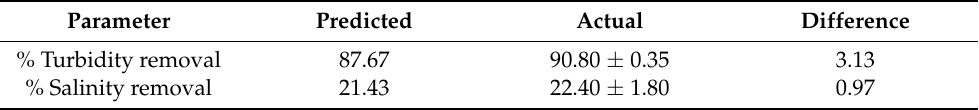
Table 8. Validation test for the predicted response parameters from carapace of M. rosenbergii